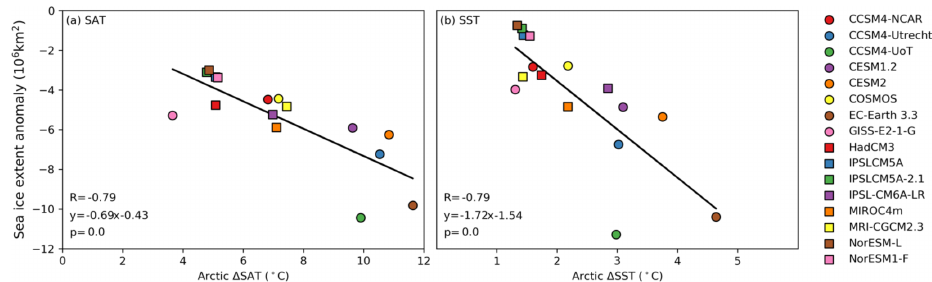
Figure 6. Correlations between annual mean SIE anomalies and (a) Arctic SAT anomalies and (b) Arctic SST anomalies. Depicted for both correlations are the correlation coefficient ( R ), the slope, and the probability value ( p ) that when the variables are not related, a statistical result equal to or greater than observed would occur.